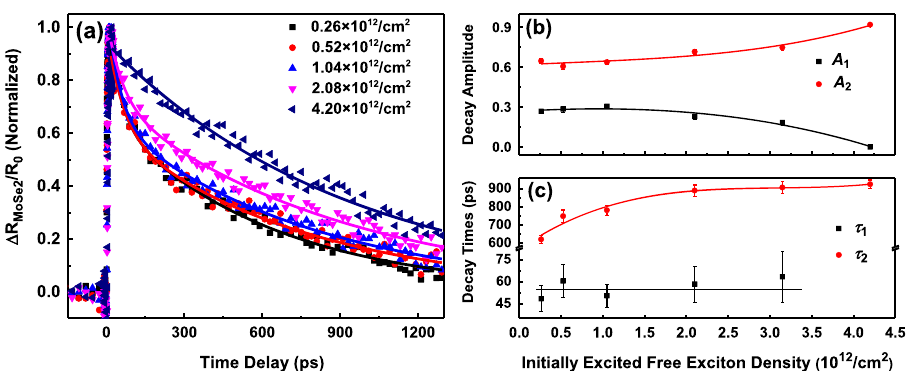
Fig. 4 a Differential re fl ectivity signal of MoSe 2 normalized at positive peaks. The solid curves are fi ttings using Eq. 3. b The fi tted decay amplitudes and c the fi tted decay times vs. free exciton density. The solid lines are guides for the